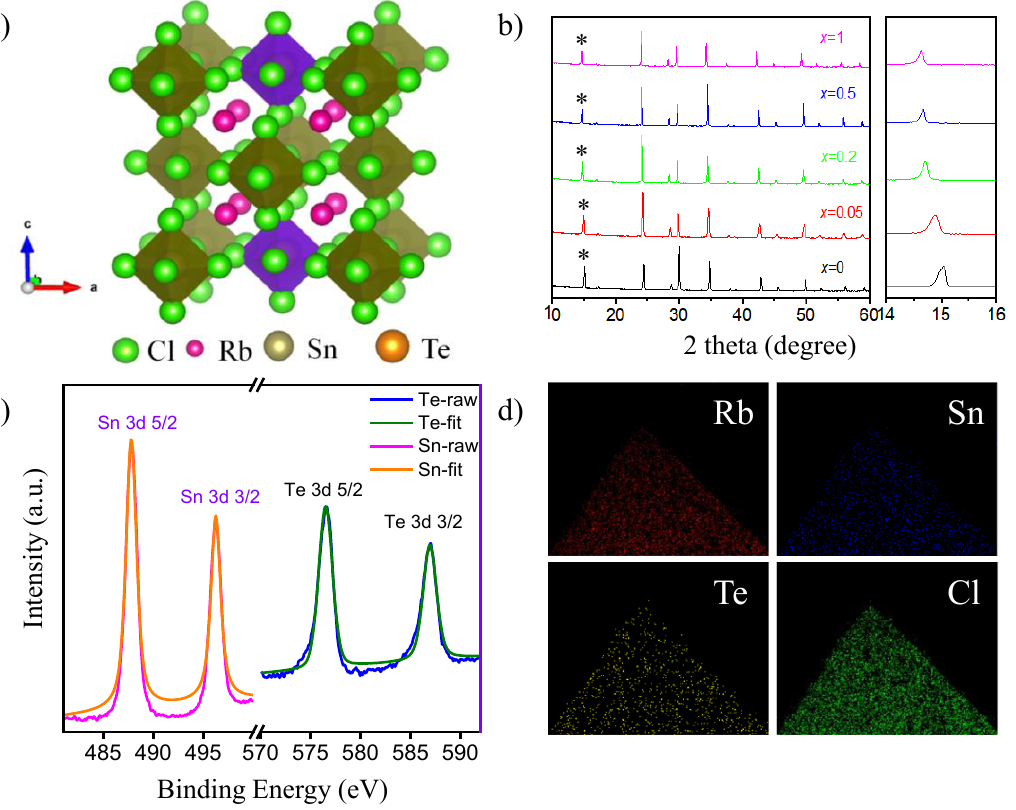
Figure 1: (a) Schematic crystal structure of Rb 2 Sn 1 − x Te x Cl 6 double perovskites. (Dark green octahedron: [SnCl 6 ] 2 − ; purple octahedron: [TeCl 6 ] 2 − ).(b)PowderX-raydiffraction(PXRD)fortheseriesofRb 2 Sn 1 − x Te x Cl 6 ,andthepeakswithasterisksintheleftpicturearedisplayedwith enlargedabscissaontheright.(c)X-rayphotoelectronspectroscopy(XPS)andpeak fi ttingforSn3 d andTe3 d orbitals,respectively.(d)Energy dispersive mapping of elements Rb, Sn, Te and Cl for the prepared